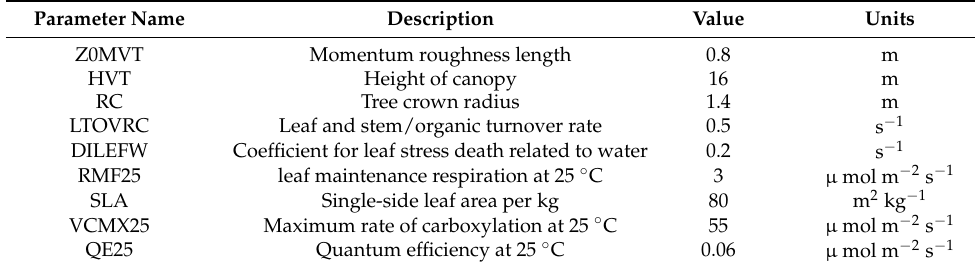
Table 2. Noah-MP’s vegetation-related parameters in mixed